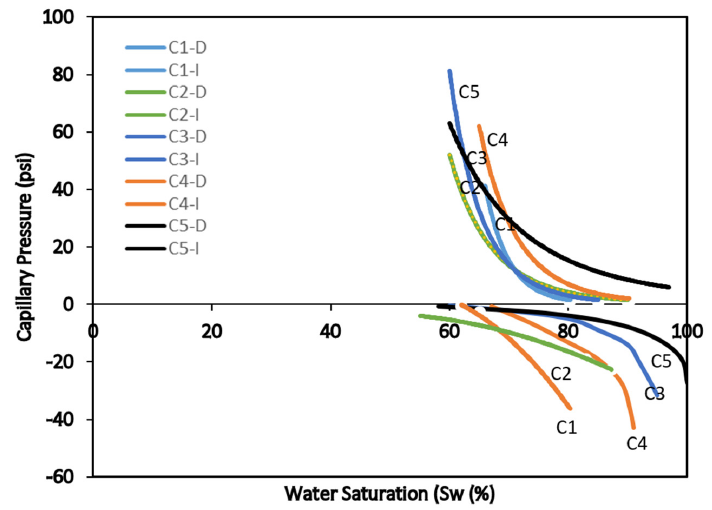
Figure 4. Capillary pressure curves for chalk samples.